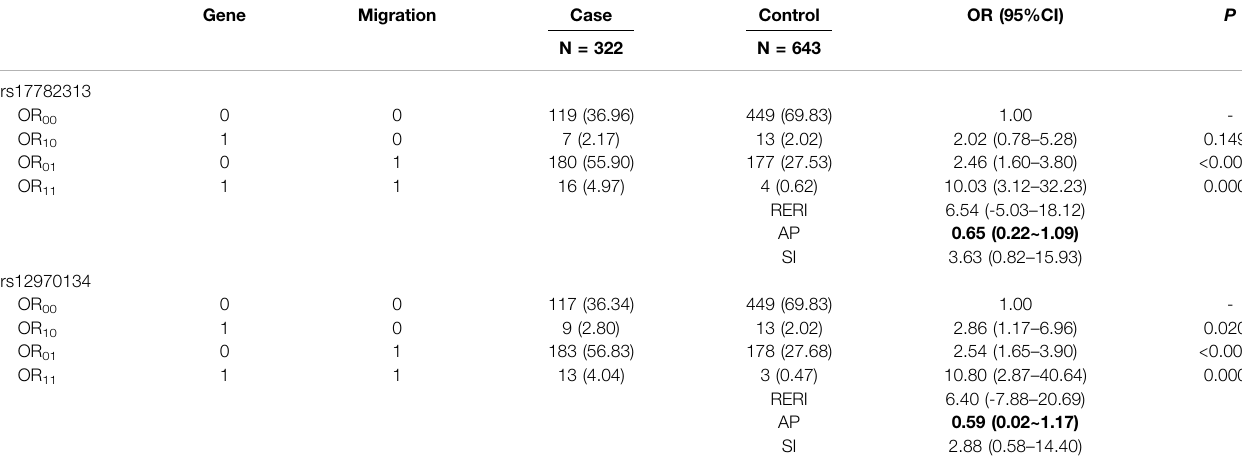
TABLE 3 | Additive interaction between MC4R gene polymorphisms and rural-to-urban migration based on the recessive inheritance mode. Gene Migration Case